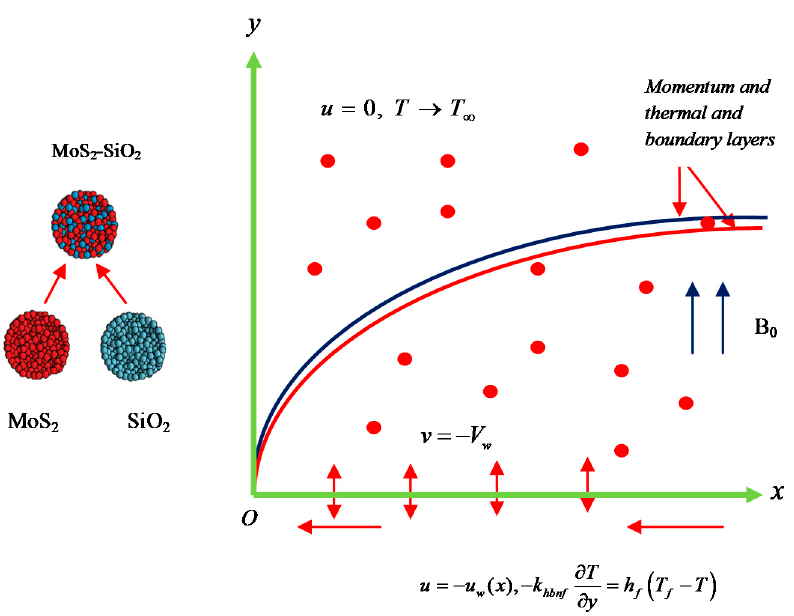
Figure 1. Physical diagram of the problem.